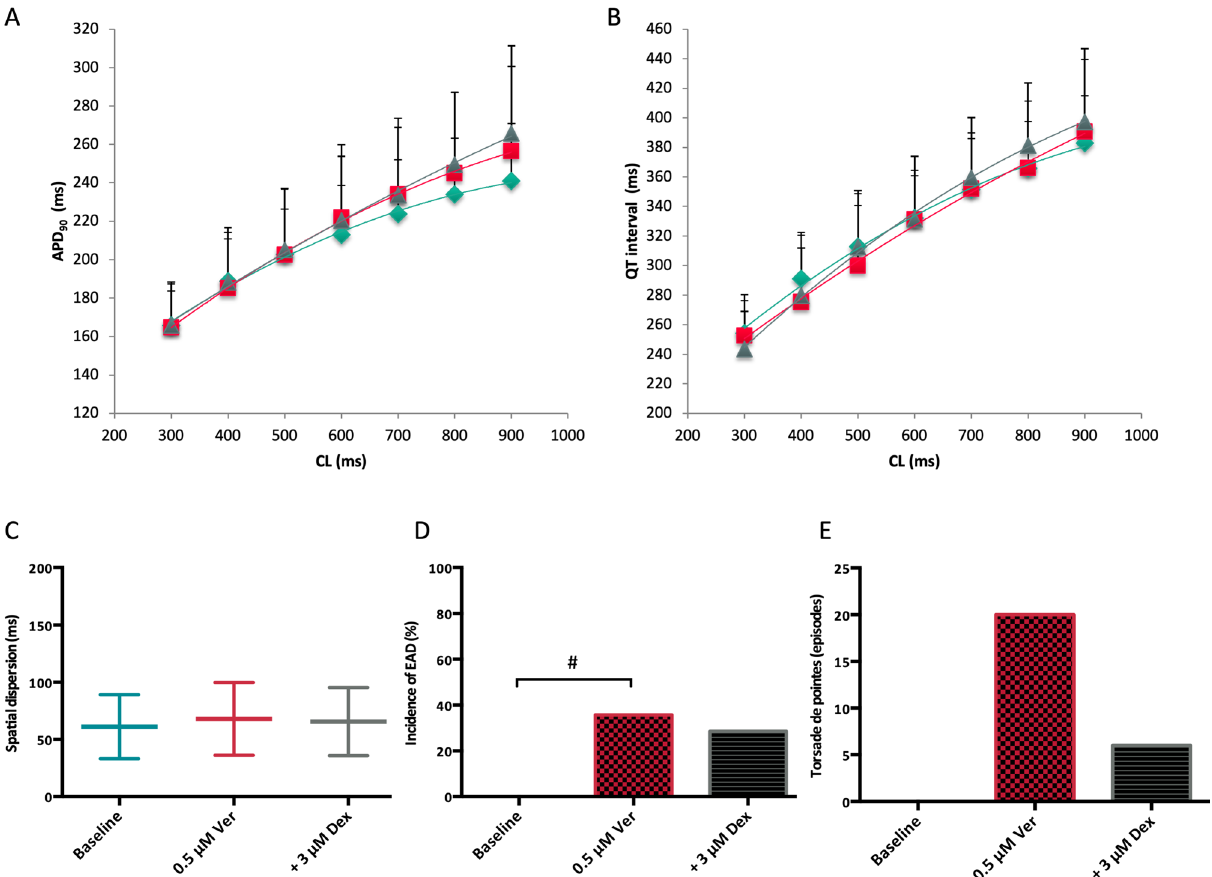
Figure 6. ( A , B ) Cycle-length dependent action potential durations (APD 90 ) and QT interval under baseline conditions (◆), after infusion of 0.5 µM veratridine ( ■ ) and after additional treatment with 3 µM dexmedetomidine ( ▲ ). ( C ) Impact of veratridine (Ver) and dexmedetomidine (Dex) on spatial dispersion of repolarization. ( D ) Occurrence of early afterdepolarizations (EAD) after administration of veratridine and after additional treatment with dexmedetomidine. ( E ) Incidence of torsade de pointes under baseline conditions, with veratridine and with the combination of veratridine and dexmedetomidine (# = p < 0.05 compared to baseline